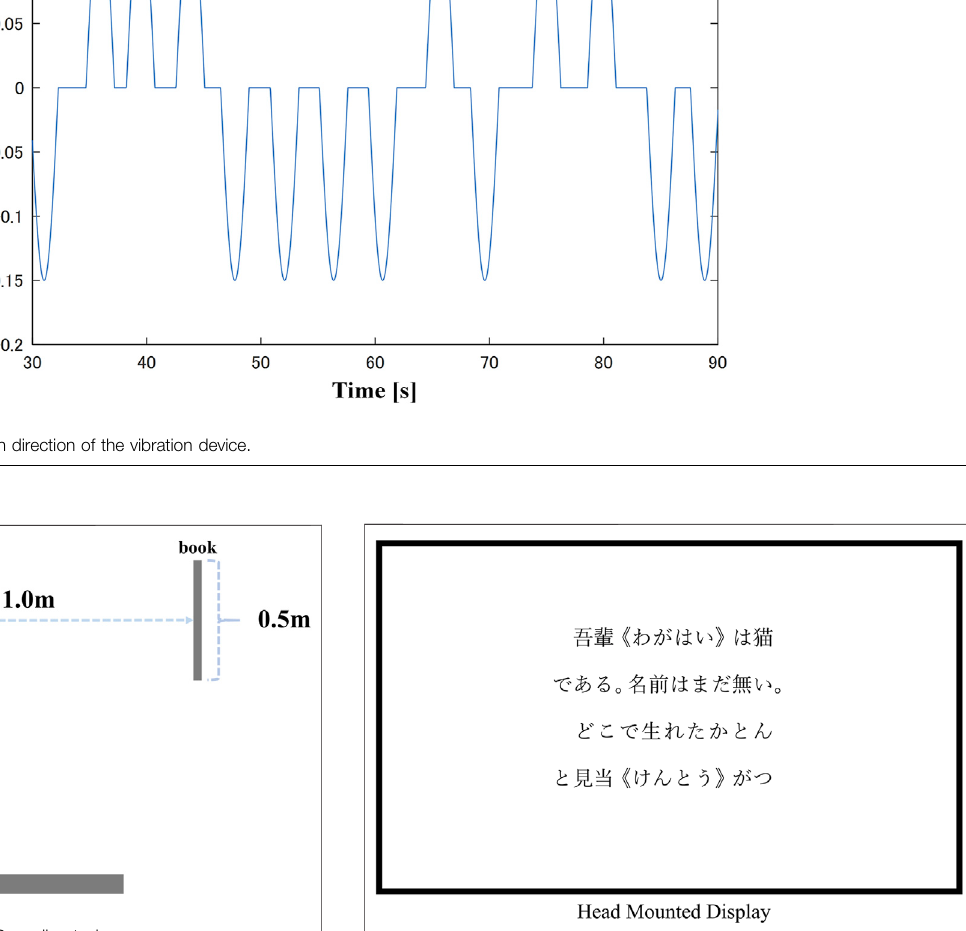
FIGURE 4 | A book displayed in the VR environment of the